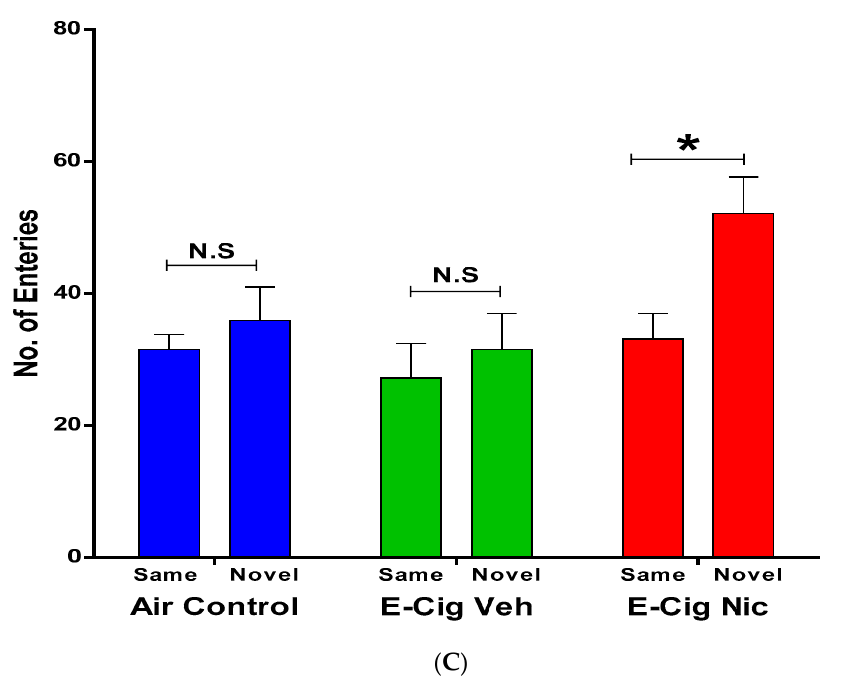
Figure 4. Recognition memory behaviors following four-week inhalation of e-cigarette vapors containing nicotine. ( A ) No. of entries into the novel object zone (n = 8/group, 4F and 4M). One-way analysis of variance (ANOVA) followed by a Tukey’s post hoc showed a significant increase in the novel object zone entries in E-cig Nic group as compared to controls. ( B ) No. of entries into the novel object zone between male and female mice in the E-cig Nic group (n = 4/group). Unpaired t -test also did not reveal any significant changes in the novel zone number entries between male and female of E-cig Nic group. ( C ) t -test showed that the number of entries into the novel object zone was significantly higher than number of entries into the same object zone in E-cig Nic group. This effect was not observed in either air or vehicle control groups (n = 8/group, 4F and 4M). Data are presented as mean ± SEM. (* p < 0.05). E-cig, electronic cigarette; E-cig Veh, electronic cigarette with vehicle only; E-cig Nic, electronic cigarette with nicotine; N.S, not significant; F, female; M, male.